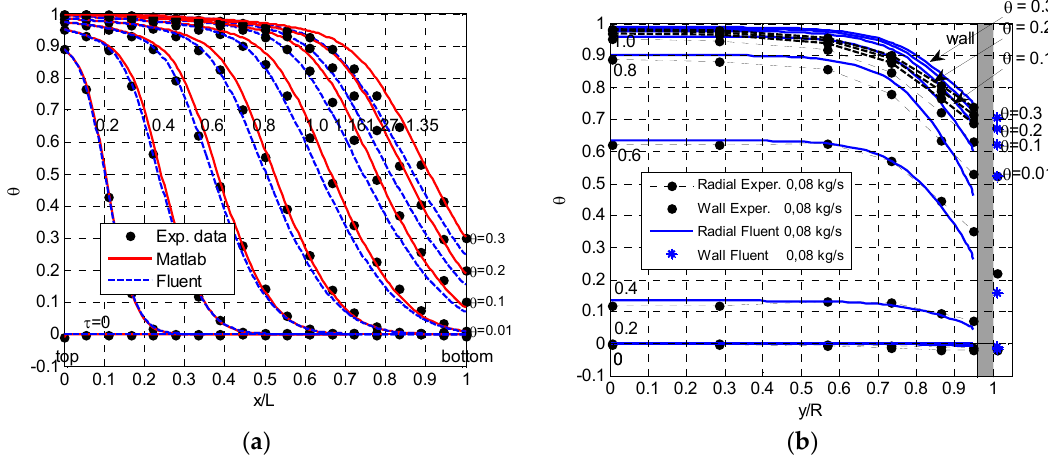
Figure 7. Fluid temperature profiles for different outlet temperatures with a mass flow rate of 0.08 kg/s ( τ = 1 for 8760 s); ( a ) Axial temperature profiles ( b ) Radial temperature profiles.